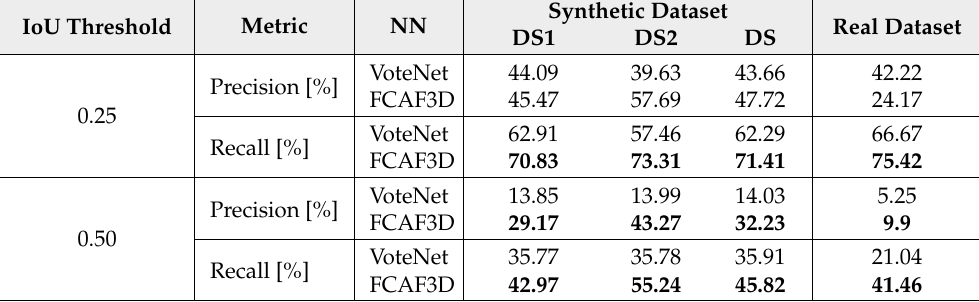
Table 5. Results of evaluation of the storage space detectors on the synthetic and real datasets. NMS IoU = 0.1; confidence threshold = 0.75. DS1 = bookshelves and negative scenes. DS2 = cabinets, desks, and (empty) tables. DS = complete dataset. Bold values represent higher precision or recall, which indicates a better